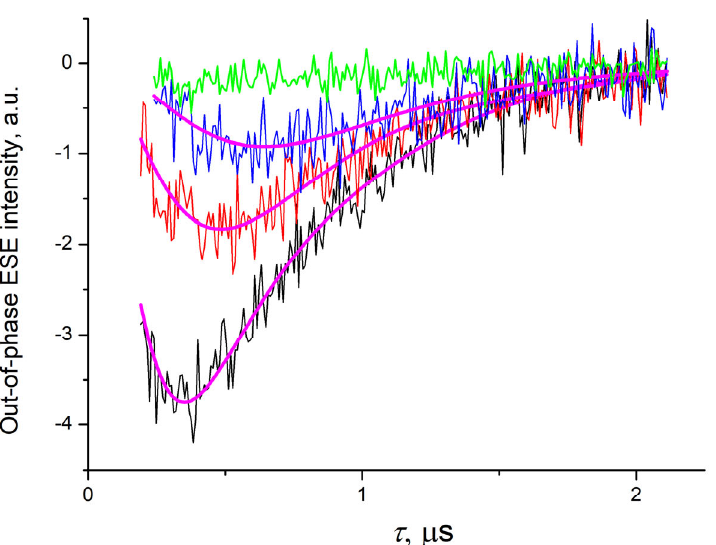
Figure 3. The out-of-phase ESEEM traces for the P3HT/s-SWCNT composite film taken at 30 K with Figure 3. The out ‐ of ‐ phase ESEEM traces for the P3HT/s ‐ SWCNT composite film taken at 30 K with DAF = 200 ns (black line), DAF = 10 µ s (red line), and DAF = 30 µ s (blue line) with their numerical DAF = 200 ns (black line), DAF = 10 μ s (red line), and DAF = 30 μ s (blue line) with their numerical simulation (thick magenta lines). Green line shows the out-of-phase ESEEM trace for the pristine simulation (thick magenta lines). Green line shows the out ‐ of ‐ phase ESEEM trace for the pristine P3HT film taken at 30 K with DAF = 200 P3HT film taken at 30 K with DAF = 200 ns.